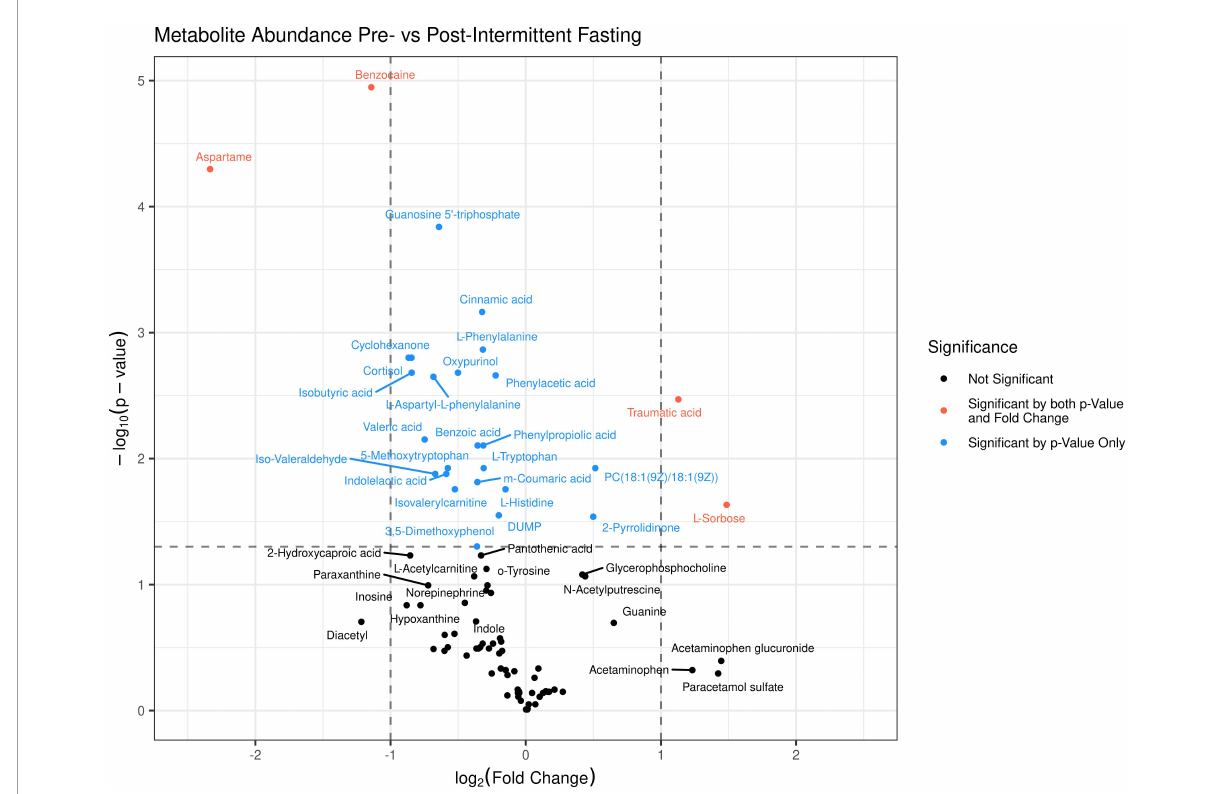
FIGURE2 A volcano plot was generated for the 89 identified metabolites in the untargeted LC-MS/MS metabolomics analysis. Above the dashed horizontal line are those metabolites that significantly differed ( P < 0.05) between before (dots to the left) and after fasting (dots to the right), in red are those metabolites that change by a Log2FC > 1, and in blue metabolites that change by a Log2FC <